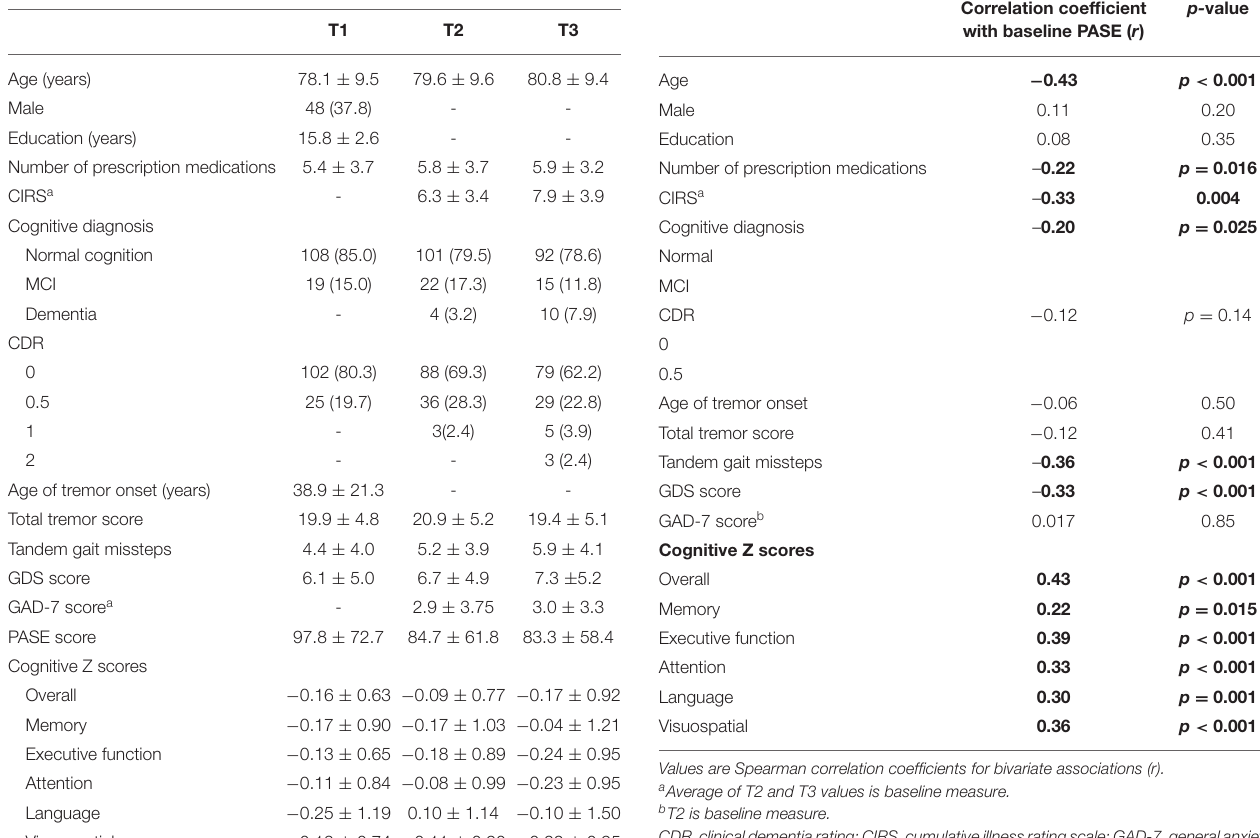
TABLE 1 | Demographic and clinical characteristics, including PASE and cognitive scores, of 127 ET cases at three time intervals.